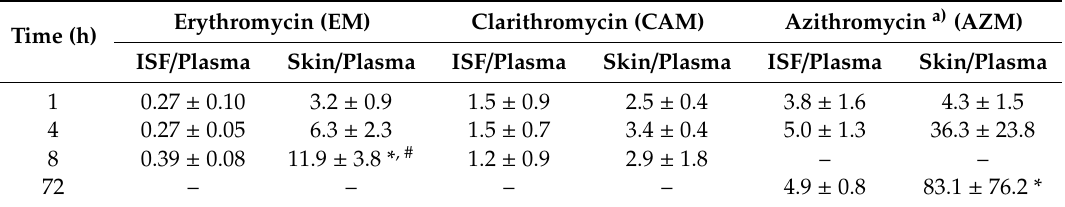
Table 2. Pharmacokinetic parameters after intravenous administration of erythromycin (5 mg/kg) and clarithromycin (20 mg/kg) to rats, and comparison with previously reported results on azithromycin (10 mg/kg).